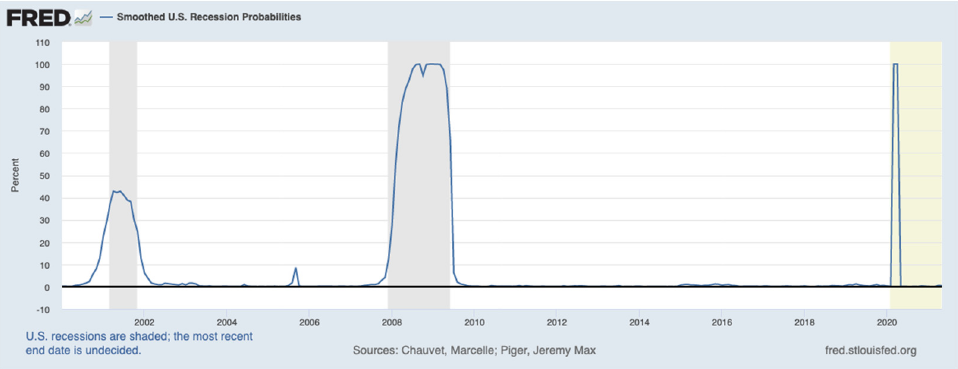
Figure 1. Smoothed U.S. recession probabilities [RECPROUSM156N], retrieved from FRED, Federal Reserve Bank of St. Louis [138].